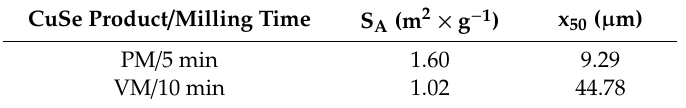
Table 2. Specific surface area, S A , and particle mean diameter, x 50 , of the final CuSe products.